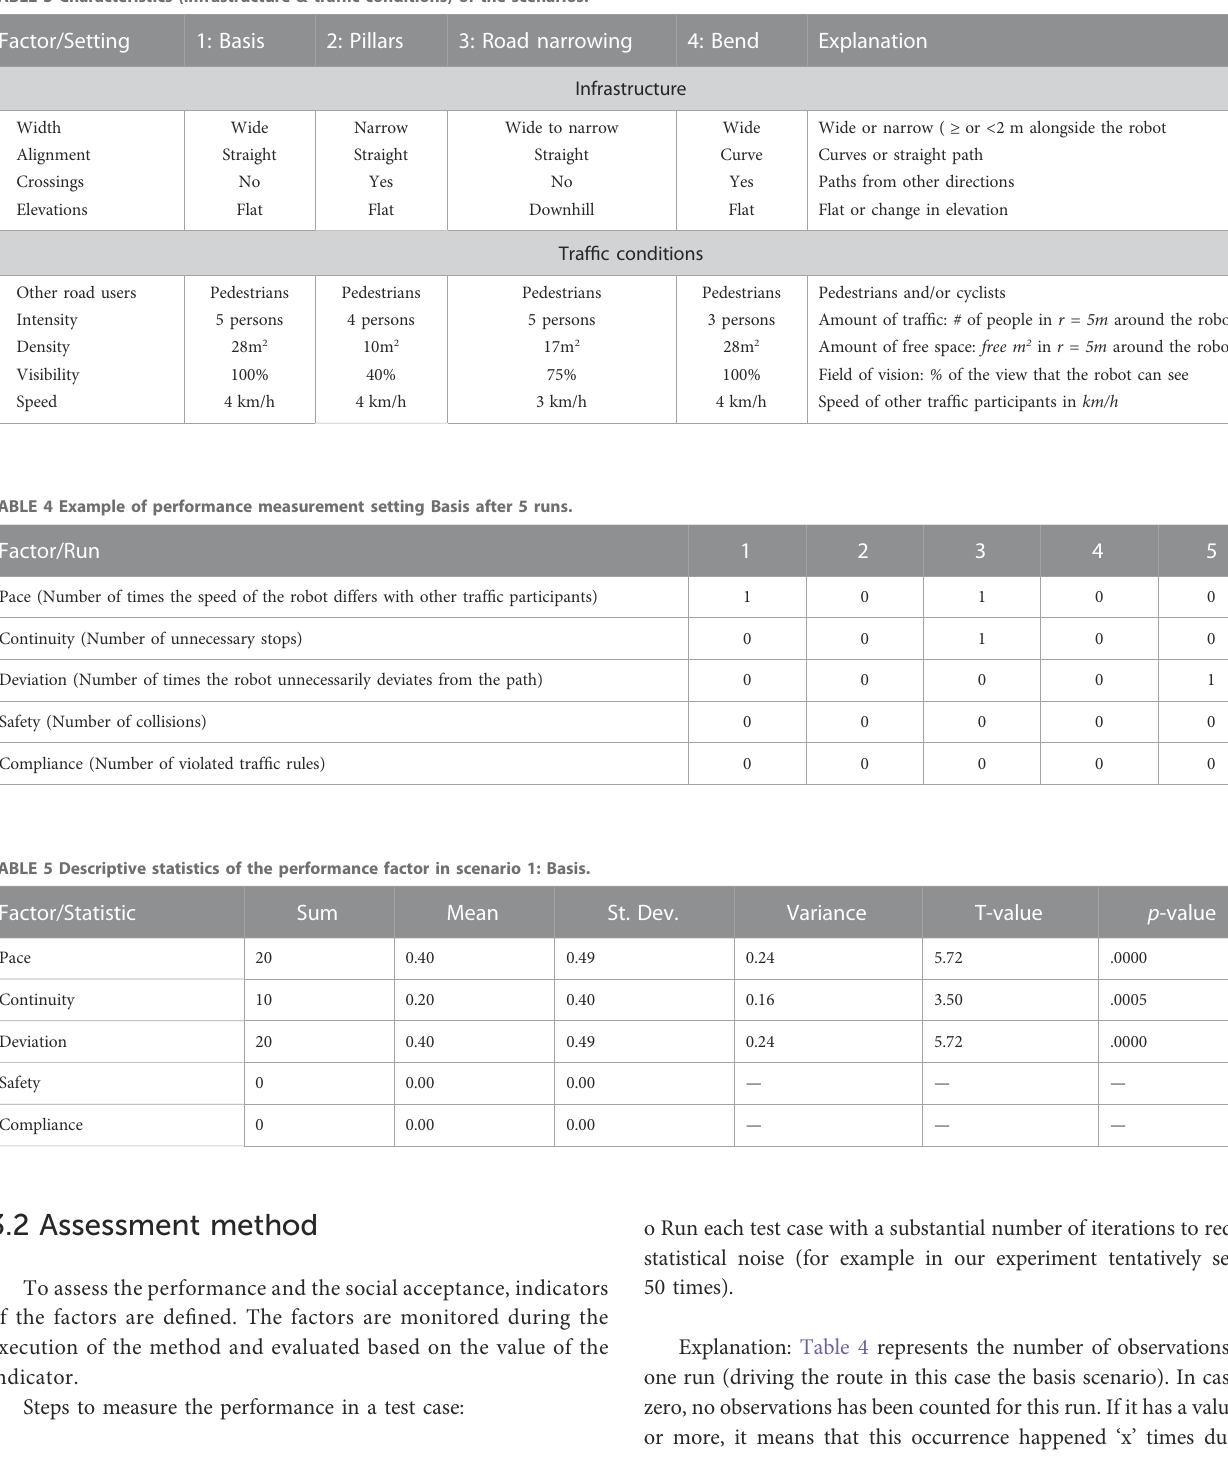
TABLE 3 Characteristics (infrastructure & traf fi c conditions) of the scenarios.